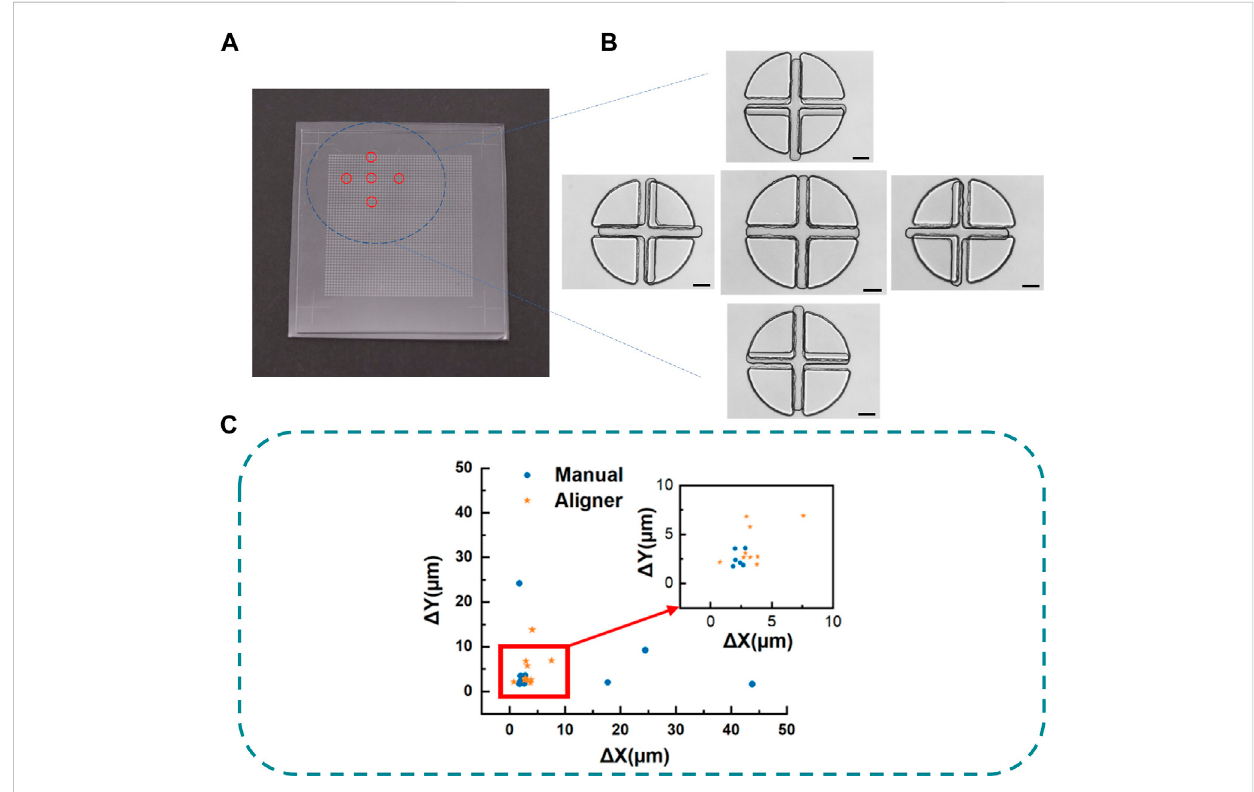
FIGURE 5 (A) Picture of the bonded PDMS chip. (B) Microscope image of the perfectly aligned micropattern in contrast to other surrounding micropatterns in the N 2 micropatterns matrix. Scalebar is 100 µm. (C) Alignment error of manual and aligner based on sacri fi cial